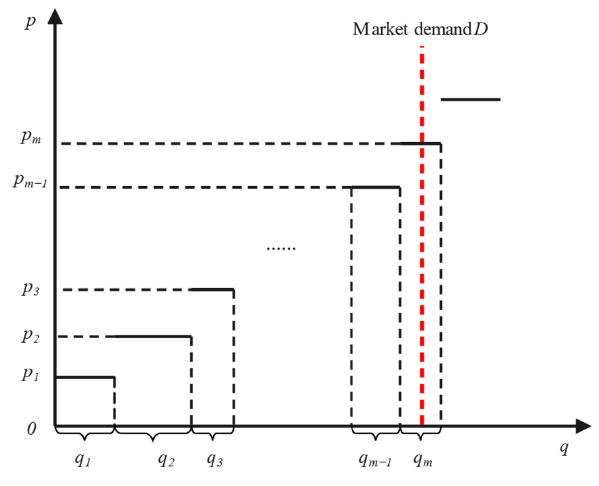
Figure 2. Schematic diagram of PAB bidding mechanism.